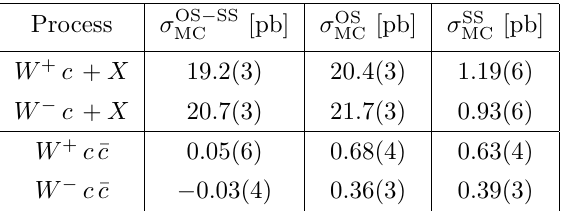
Table 7 . Same as table 6, but for W ± + D -meson production according to the analysis of ref. [21], with PYTHIA8 configured according to the ATLAS A14 central tune.